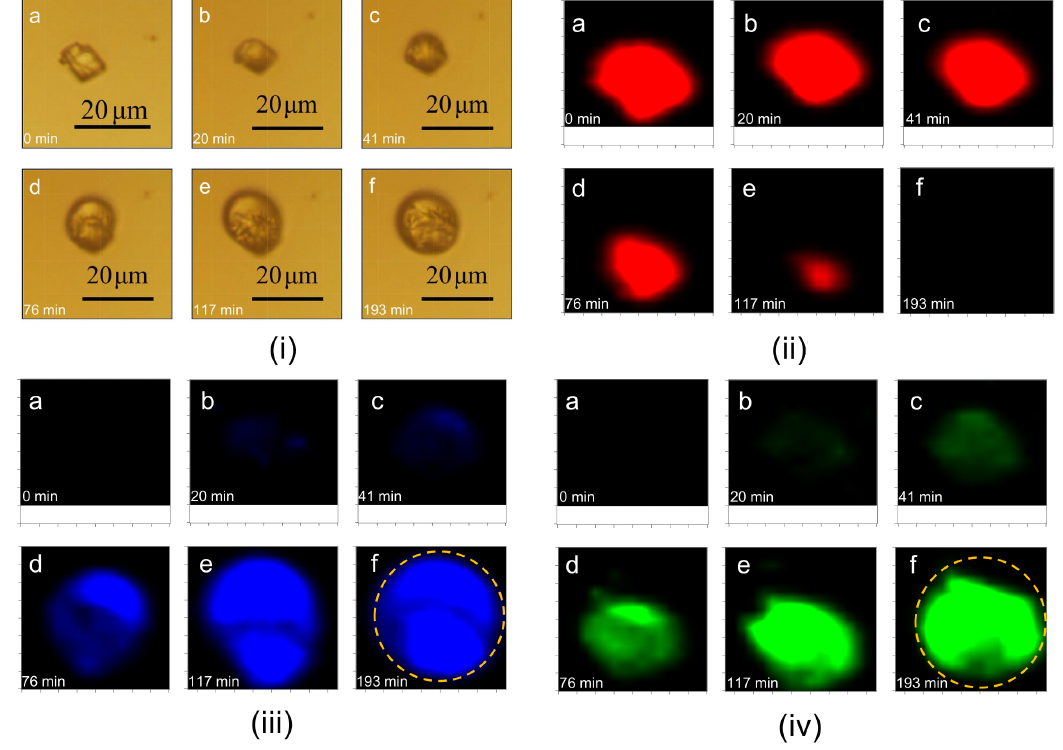
Figure 2. Microscopic image (i) and Raman mapping image of carbonate (ii) , nitrate (iii) , and sulfate (iv) on the CaCO 3 particle during the multiphase reaction SO 2 with O 2 / NO 2 / H 2 O on the particle. Panels (a–f) correspond to the reaction times of 0, 20, 41, 76, 117, and 193min. SO 2 : 75ppm, NO 2 : 75ppm, RH: 72%, O 2 : 20%. The mapping images of carbonate, nitrate, and sulfate are made using the peak area at 1050, 1010, and 1087cm − 1 , respectively. The red, blue, and green colors indicate the peak intensity of carbonate, nitrate, and sulfate, respectively. The dashed lines in panel (iii.f) and (iv.f) indicate the shape of the droplet at the end of the